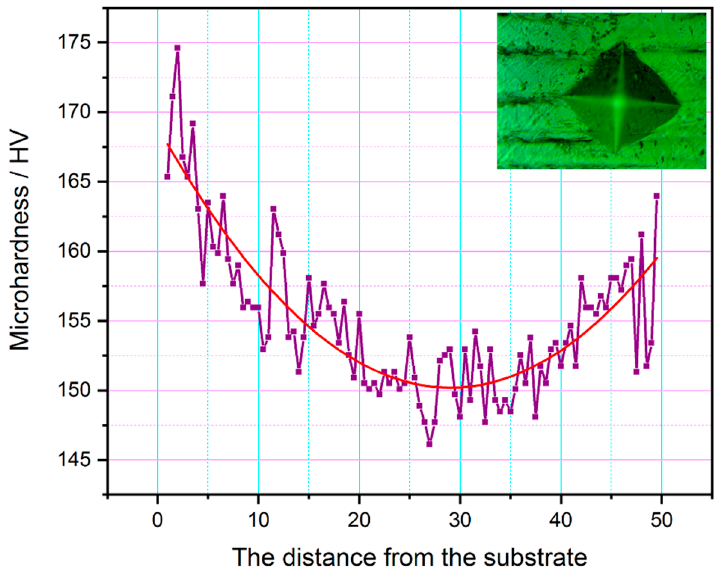
Figure 10. Microhardness distribution on the whole cross-section of the as-deposited wall along the building direction.